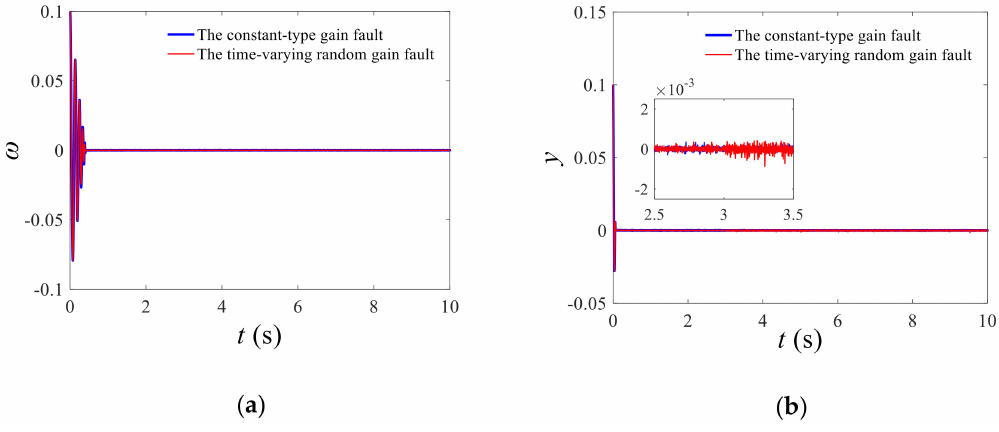
Figure 4. State trajectories of the HTGS under an actuator constant-gain fault. ( a ) ω ( t ) − t ; ( b ) y ( t ) − t